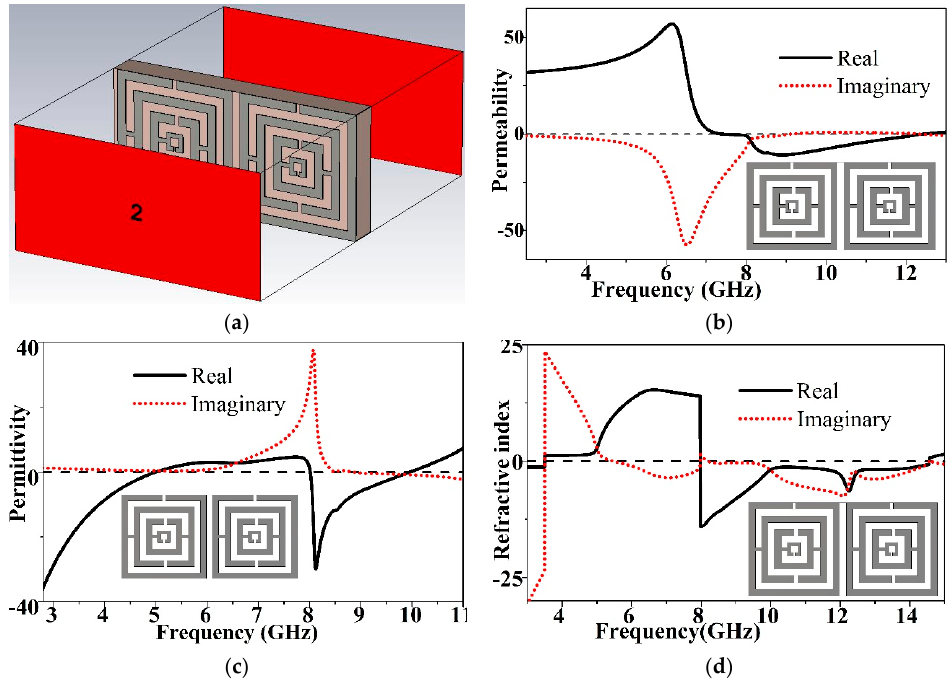
Figure 4. 1 × 2 array characteristics ( a ) Simulation setup ( b ) Permeability ( c ) Permittivity ( d ) Refractive index.